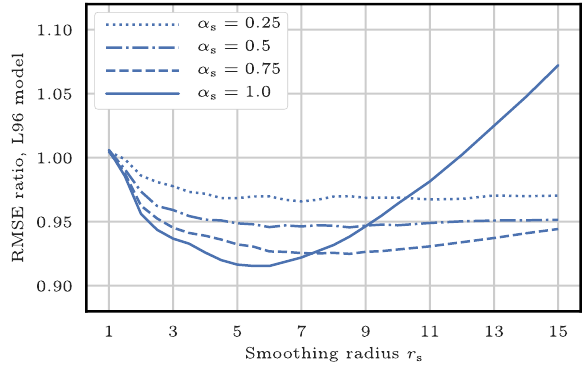
Figure 11. RMSE as a function of the ensemble size N e for the S(IR) x R and the S(IR) x R c algorithms with N b = 40 and 10 blocks of size 1 and 4 grid points, respectively. The scores are displayed in units of the RMSE of the S(IR) x R algorithm with N b = 40 blocks of size 1 grid point.